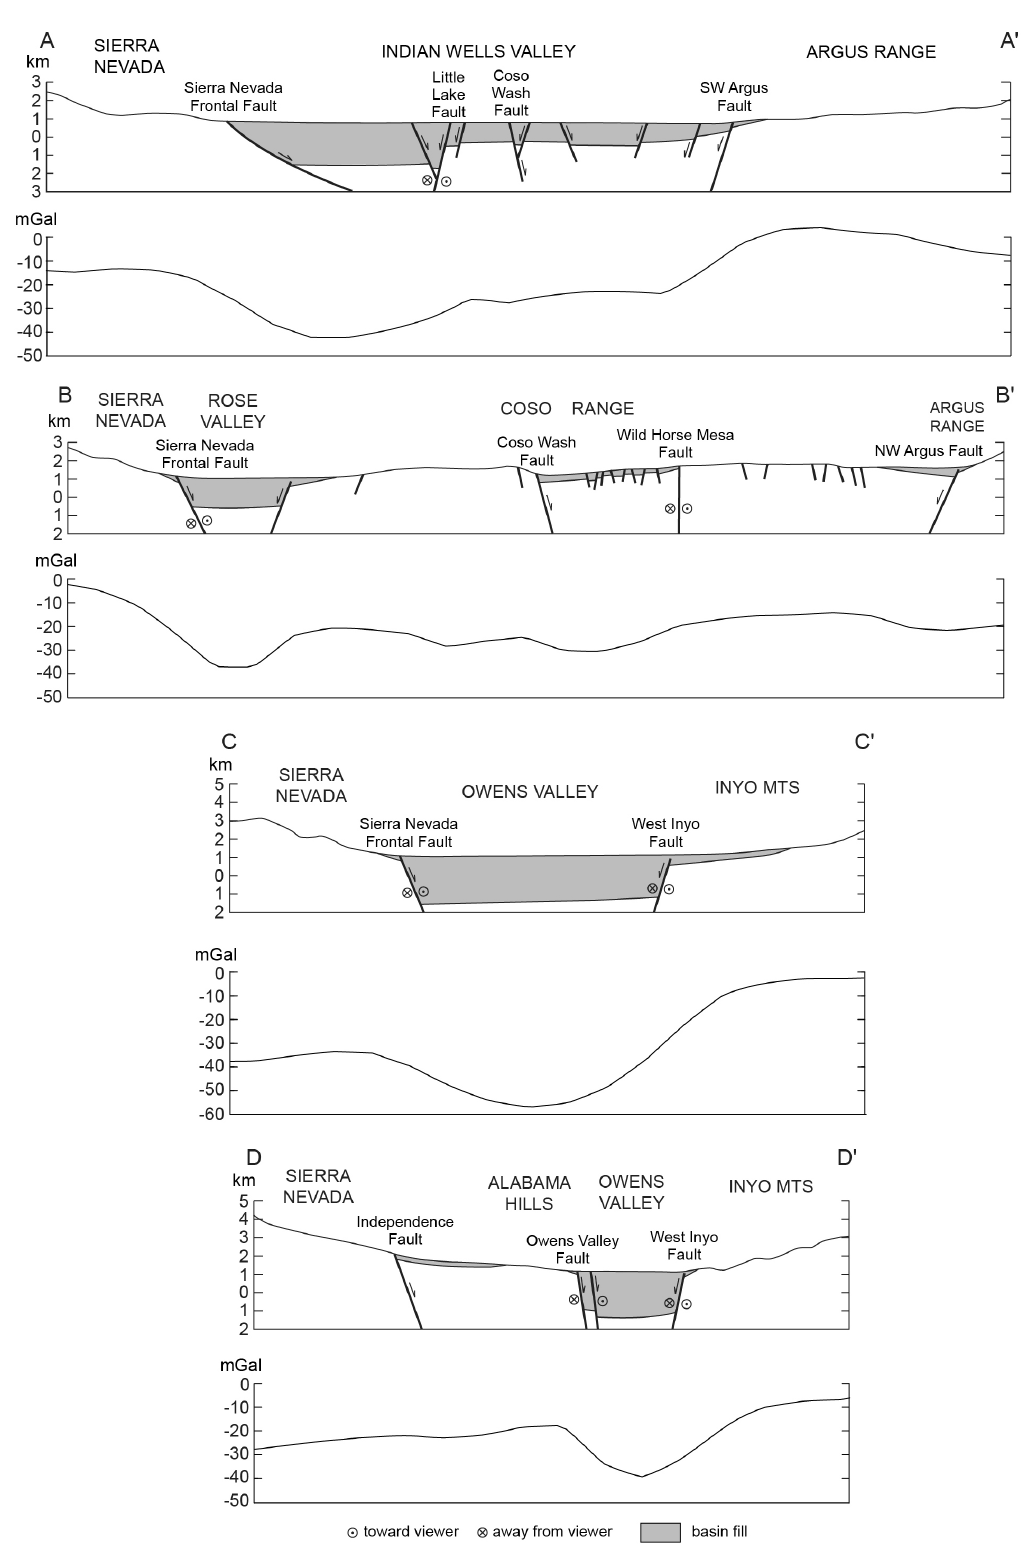
Figure 10. Structural cross sections across the East Sierra Valley System (ESVS), with corresponding gravity profiles. Locations of sections are shown in Figure 5. No vertical exaggeration. Shading represents Quaternary sedimentary and volcanic deposits, with thicknesses based on inversion of gravity data [53]. Structural data from various sources